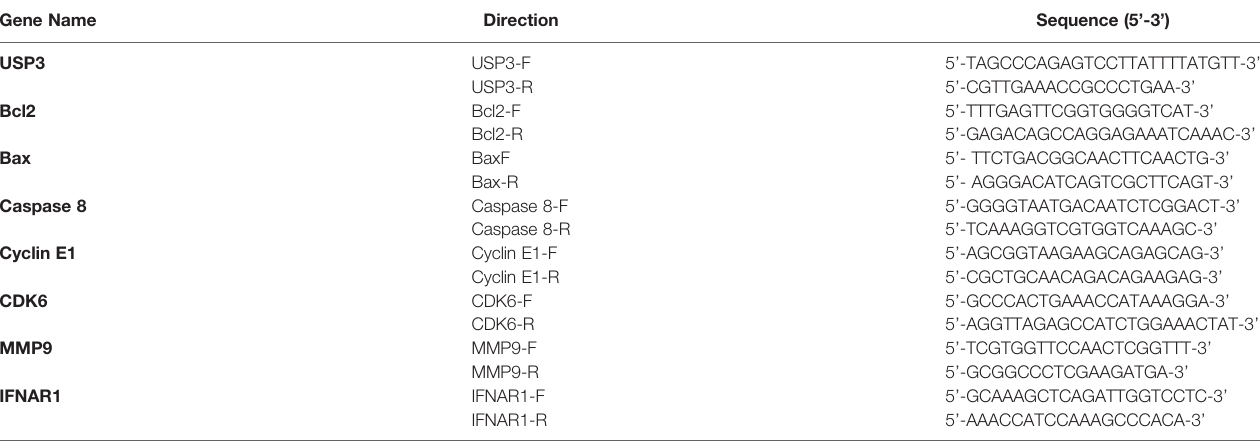
TABLE 1 | Primers designed for qRT – PCR validation of